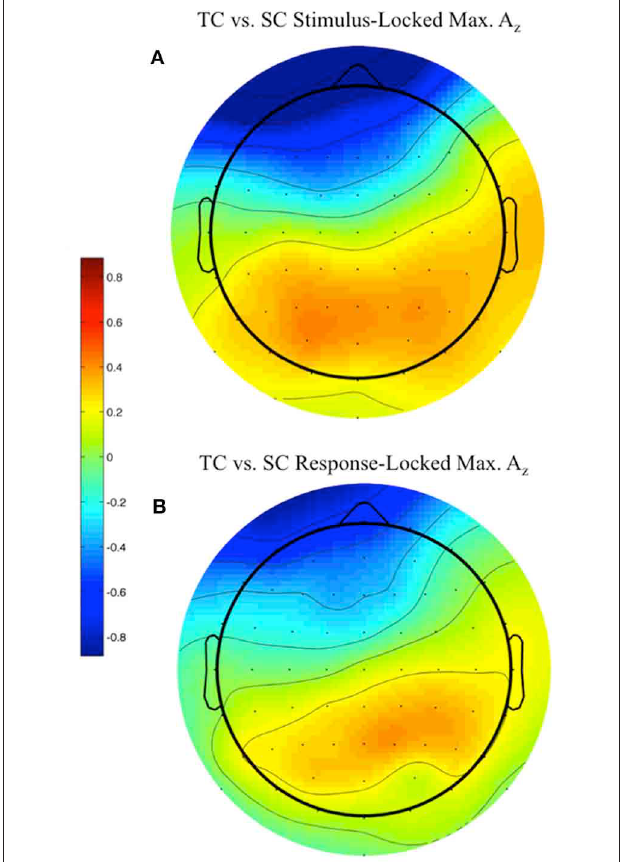
FIGURE 6 | Stimulus-locked (A) and response-locked (B) forward model across discriminating subjects at window of maximum A z for front response-correct (target correct or TC) vs. side response-correct (standard correct or SC) discrimination. Subjects are filtered by within-subject false discovery rate threshold (All subjects used in response-locked; S1, S3, and S6 removed from stimulus-locked). Forward model values (unitless) are within-subject normalized at each electrode site before averaging. More positive values indicate discriminating activity coupled with correct identification of the target stimulus, while more negative values indicate correct identification of the standard. The distribution of electrode coupling with target stimuli reflects in both locking conditions earlier work on auditory oddball scalp